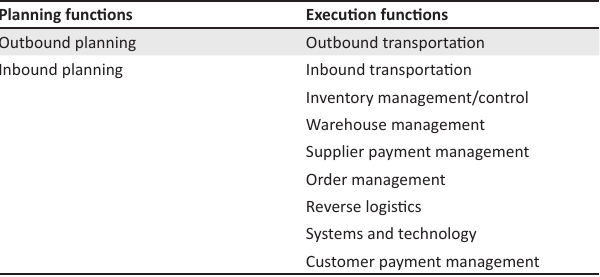
TABLE 1: Categorisation of logistics functions. Planning